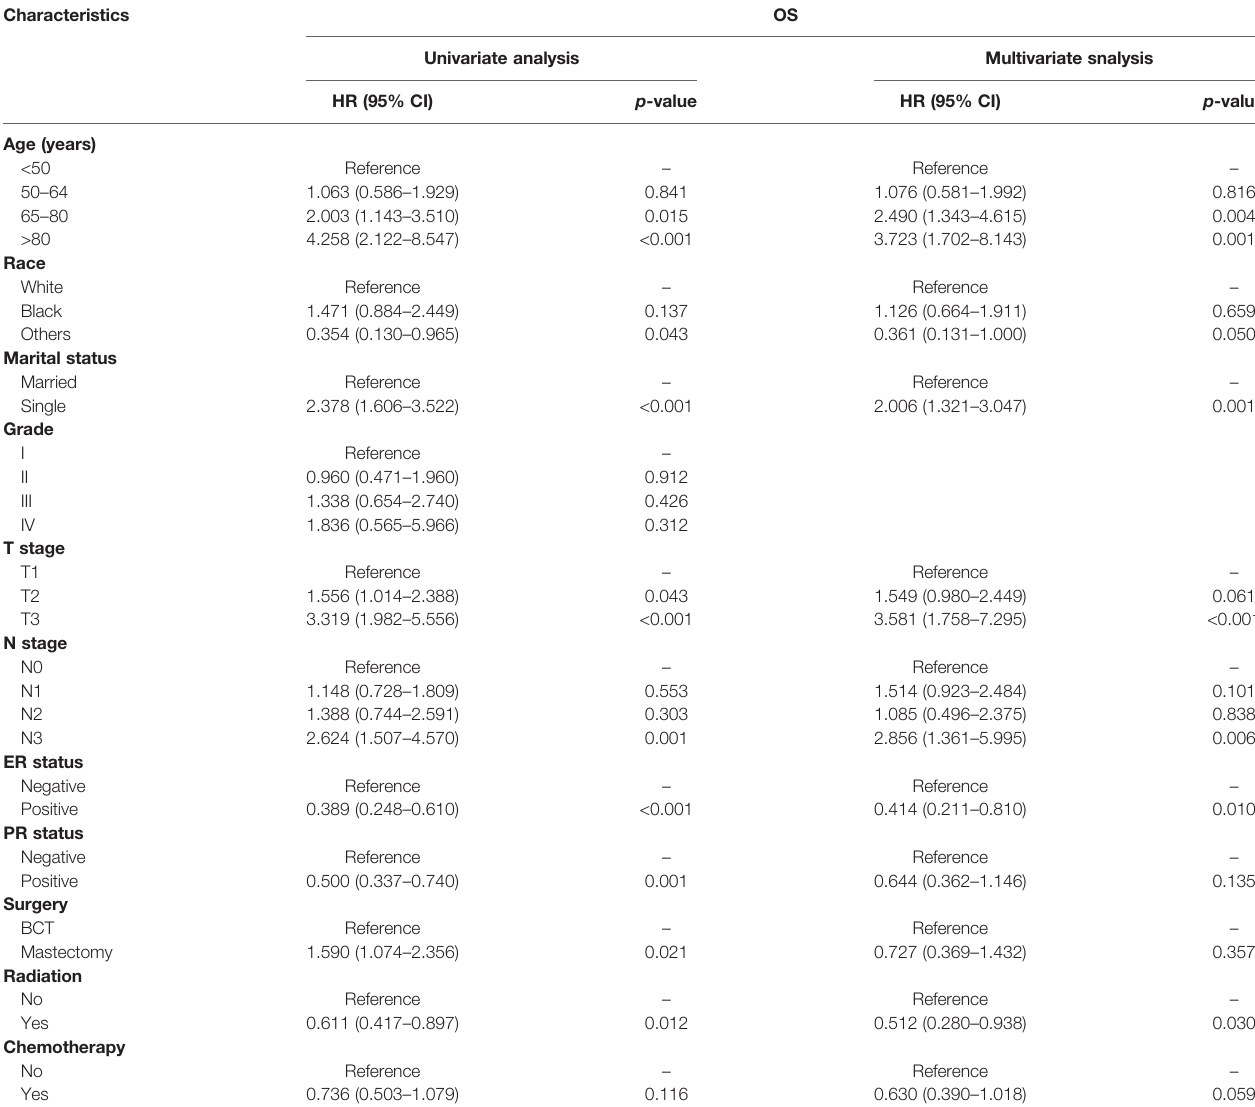
TABLE 2 | Univariate and multivariate analysis of OS of patients with early-stage IMPC.